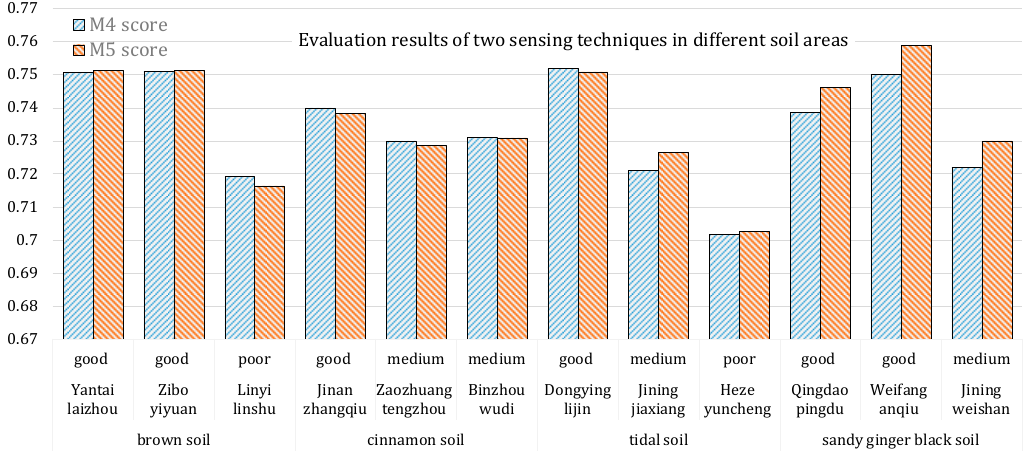
Figure 5. Evaluation results of the two sensing methods in different soil areas.